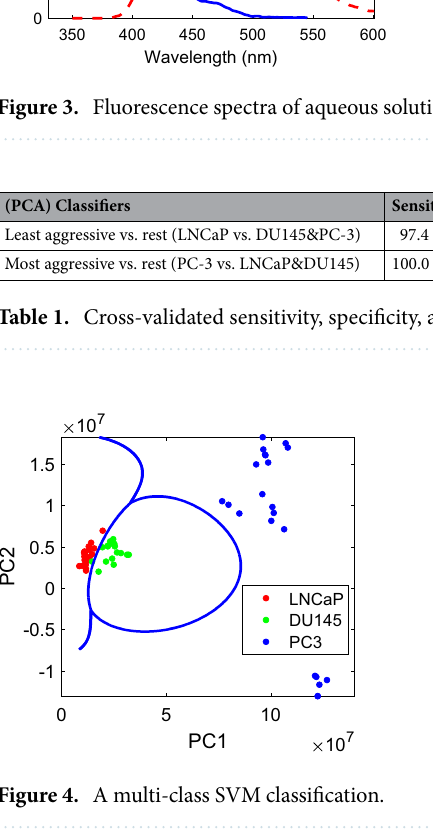
Fig. 3 are normalized to the spectra maxima, and consistent with literature data with emission maxima shown around ~ 360 nm, ~ 395 nm, ~ 460 nm for the three chemicals of tryptophan, lactate and NADH, respectively. The SVM classifier was further evaluated with LOOCV. The corresponding ROC curves are shown in Fig. 2c. The resulting values of sensitivity, specificity, accuracy and AUROC are shown in Table 1. A multi-class SVM classification was also performed for PC1 and PC2 using a Gaussian kernel 25 . The classi- fier trained using all data is shown in Fig. 4. The LOOCV sensitivity, specificity, and accuracy were found to be 100.0%, 94.1%, and 100.0%, along with a total accuracy of 98.4%. To further evaluate the model, the optimal number of PCs, r opt , as a hyperparameter was evaluated using multi-class classification by SVM and a nested LOOCV. The r opt value for PCA-SVM was found to be 3 based on the maximum accuracy. The external LOOCV was used for a final evaluation. The classification accuracies for all the cell types were found to be 95.8%, 100%, and 100% for LNCaP, DU145 and PC-3 respectively. A total accuracy was found to be 98.4%. The other multivariate analysis method tested in this study was NMF. An overlay plot of the first two NMF- extracted nonnegative components (NCs) i.e., feature spectra is shown in Fig. 5a. In the initial analysis, r -value of 2 was used. As shown in Fig. 2a, the 1st NMF spectral feature shows a strong similarity with the fluorescent emission profile of tryptophan 10 . The NADH peak about 460 nm is not prominent. The 2nd NMF feature spec- trum shows a NADH peak along with a peak at ~ 400 nm, which again might be due to lactate. Due to the inher- ent non-negativity of NFL spectra, the resulting feature spectra obtained by utilizing the positively-constrained technique, NMF, are more easily interpretable than with PCA. Figure 5b indicates both the relative concentrations of tryptophan and NADH and/or lactate (NADH/ lactate) increasing with the aggressiveness of the cancer cells. Table 2 illustrates the LOOCV sensitivity, specificity and overall accuracy based on the two NCs. The LOOCV ROC curves are shown in Fig. 5c. Similarly, a multi-class SVM classification was also performed with a Gaussian kernel using NC1 and NC2, as shown in Fig. 6. The LOOCV sensitivity, specificity, and accuracy were found to be 100.0%, 94.1%, and 100.0%, along with a total accuracy of 98.4%.